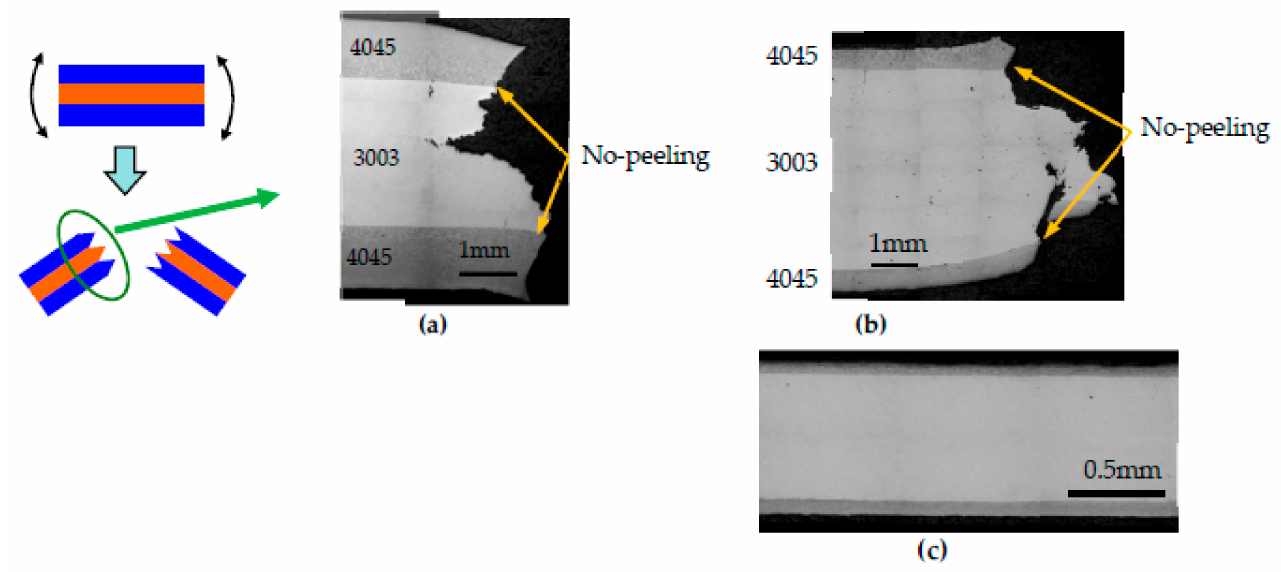
Figure 11. Cross-section of fracture area after bending-fracture test and after cold rolling. ( a ) Strip shown in Figure 10a; ( b ) strip shown in Figure 10b; ( c ) cold-rolled strip shown in Figure